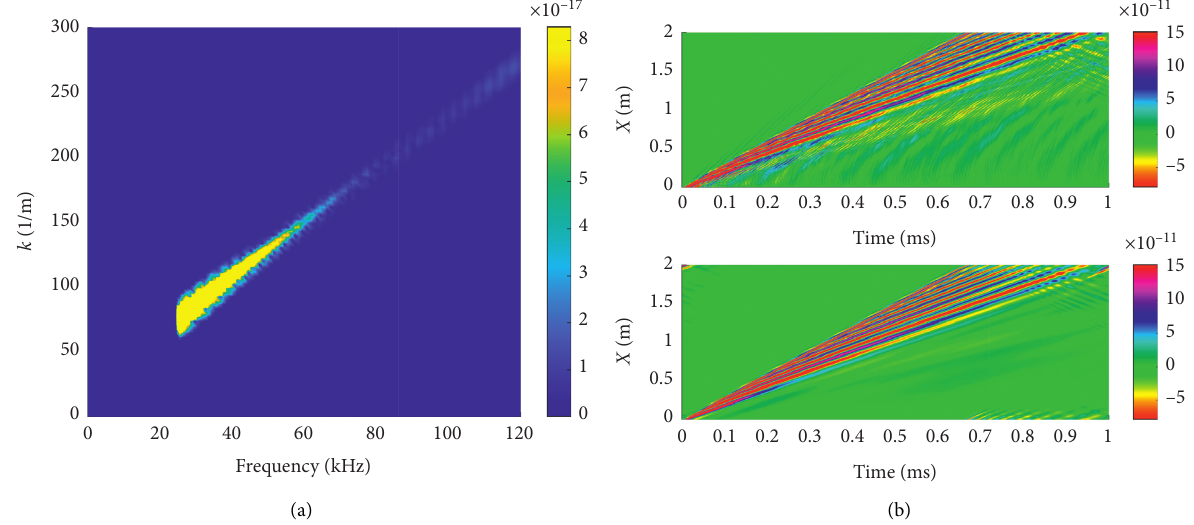
Figure 10: Extracted wavefield of W0 using the selected frequency band. (a) Filtered spectrum and (b) reconstructed time-space domain compared with original